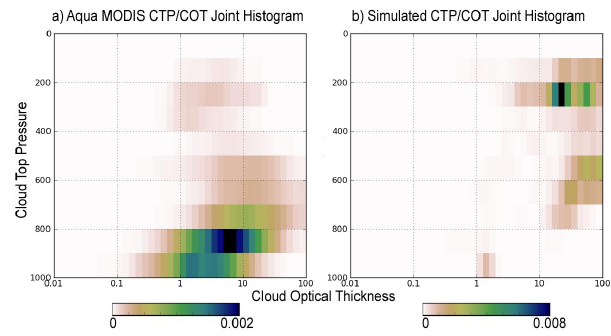
Fig. 4. Joint histograms of cloud optical thickness vs. cloud top pressure for actual (a) and model-based (b) cloud fields covered by Aqua MODIS 2012 day 228 at 12:00UTC.